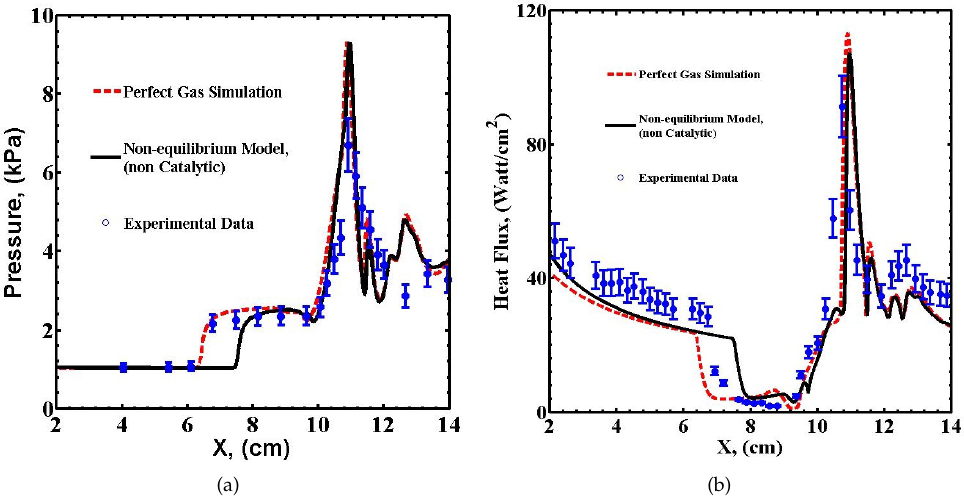
Figure 3. Computational results for Run 1, Table 1, using perfect gas and non-equilibrium Navier–Stokes models. ( a ) Surface pressure; ( b ) Heat transfer